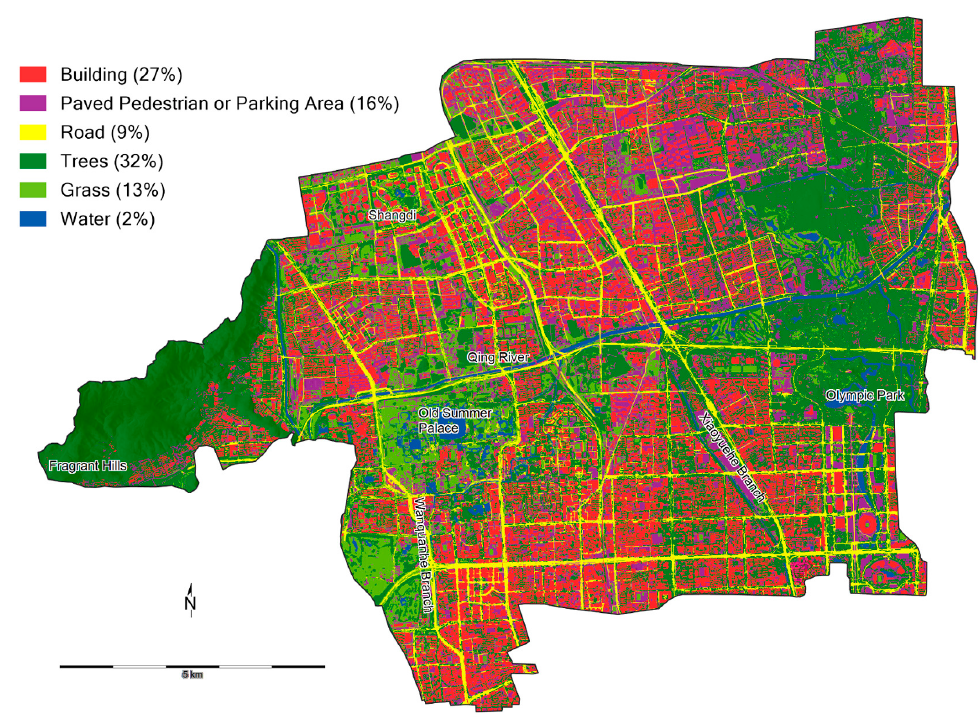
Figure 5. Upper Qing Catchment study area, Beijing (133 km 2 ) with land cover classified using Bayes classifier followed by application of refining rules.